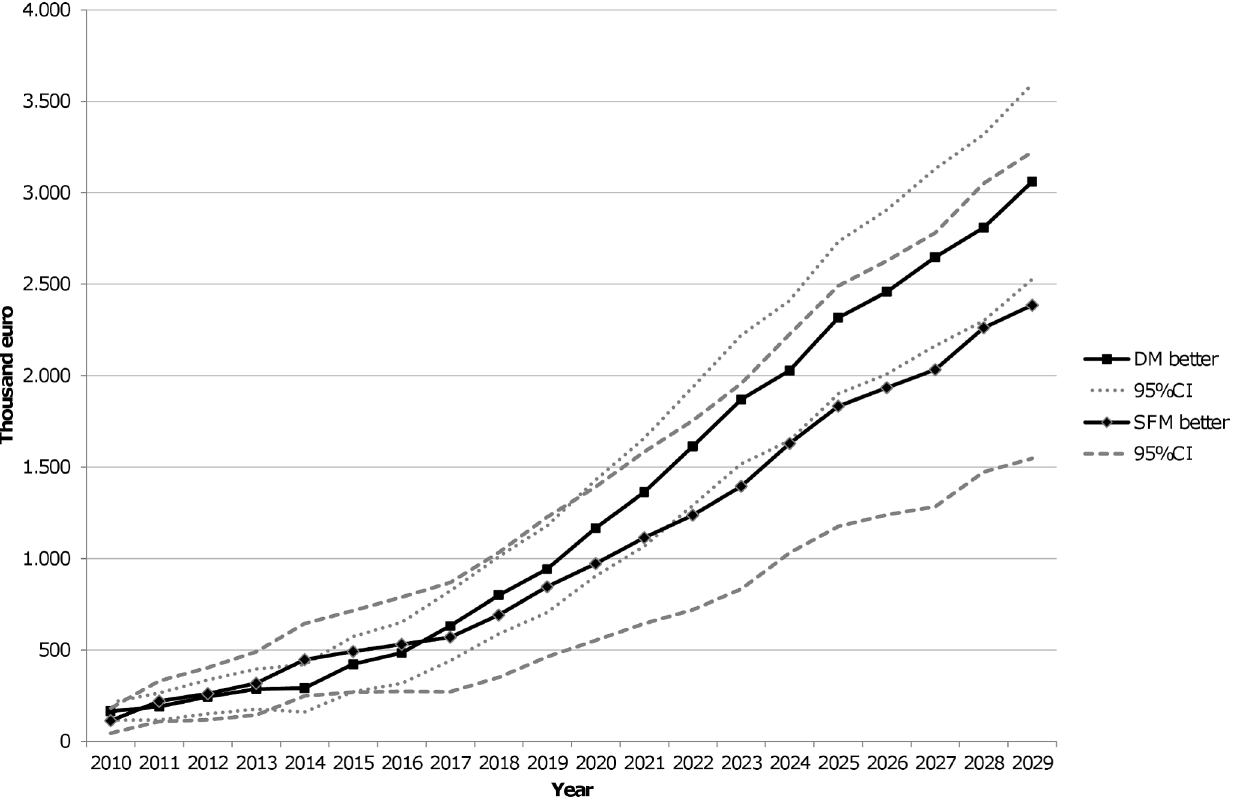
Figure 3. Sensitivity analysis results. DM better (n=921 runs): Digital mammography higher detection rate and lower recall rate, or digital higher detection rate and similar recall rate, or digital lower recall rate and similar detection rate. SFM better (n=469 runs): Screen-film mammography higher detection rate and lower recall rate, or SFM higher detection rate and similar recall rate, or SFM lower recall rate and similar detection rate. Intermediate scenario (n=610 runs, not shown): Digital higher detection rate and SFM lower recall rate, or digital lower recall rate and SFM higher detection rate, or both similar detection and recall rates. CI: Confidence Interval.